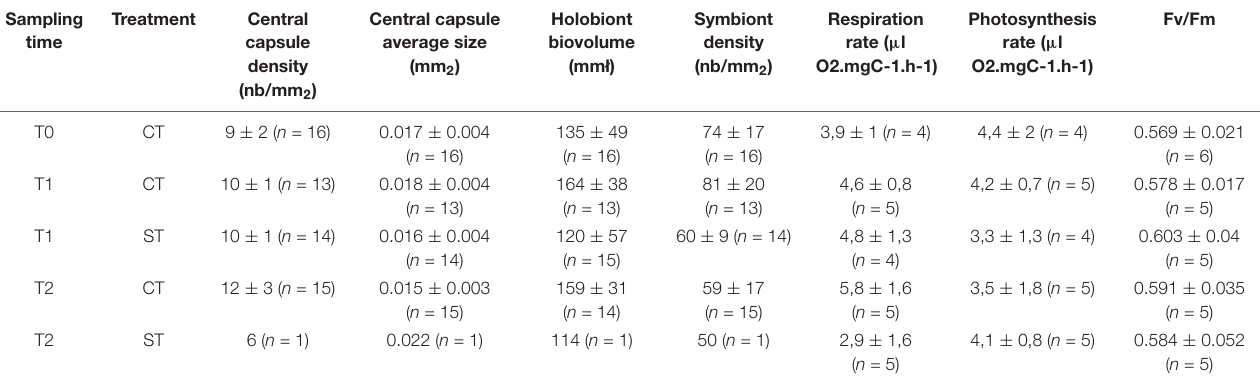
TABLE 1 | Summary of the statistics of the morphological and physiological measurements in control (CT) and heat-stressed (ST) colonies of Collozoum pelagicum at 3 sampling times (T0, T1, and T2). Sampling time